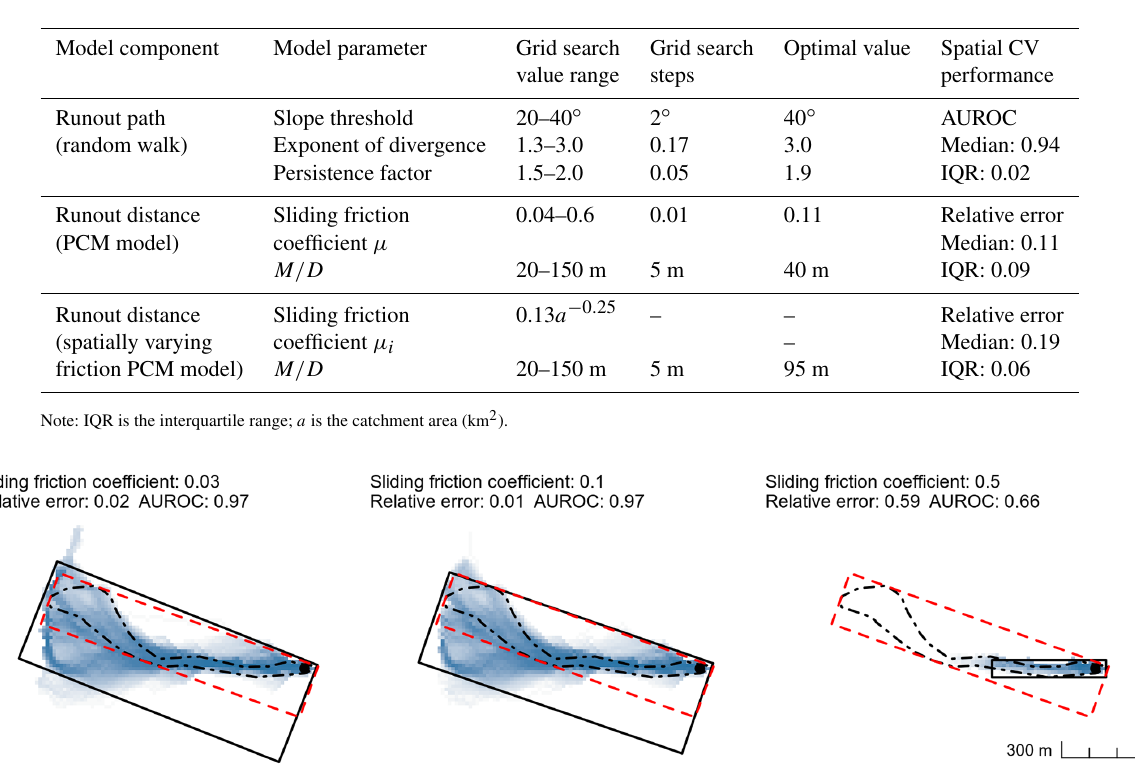
Table 2. Runout model grid-search optimization setup and results. Optimization performance was assessed using spatial cross-validation (CV).